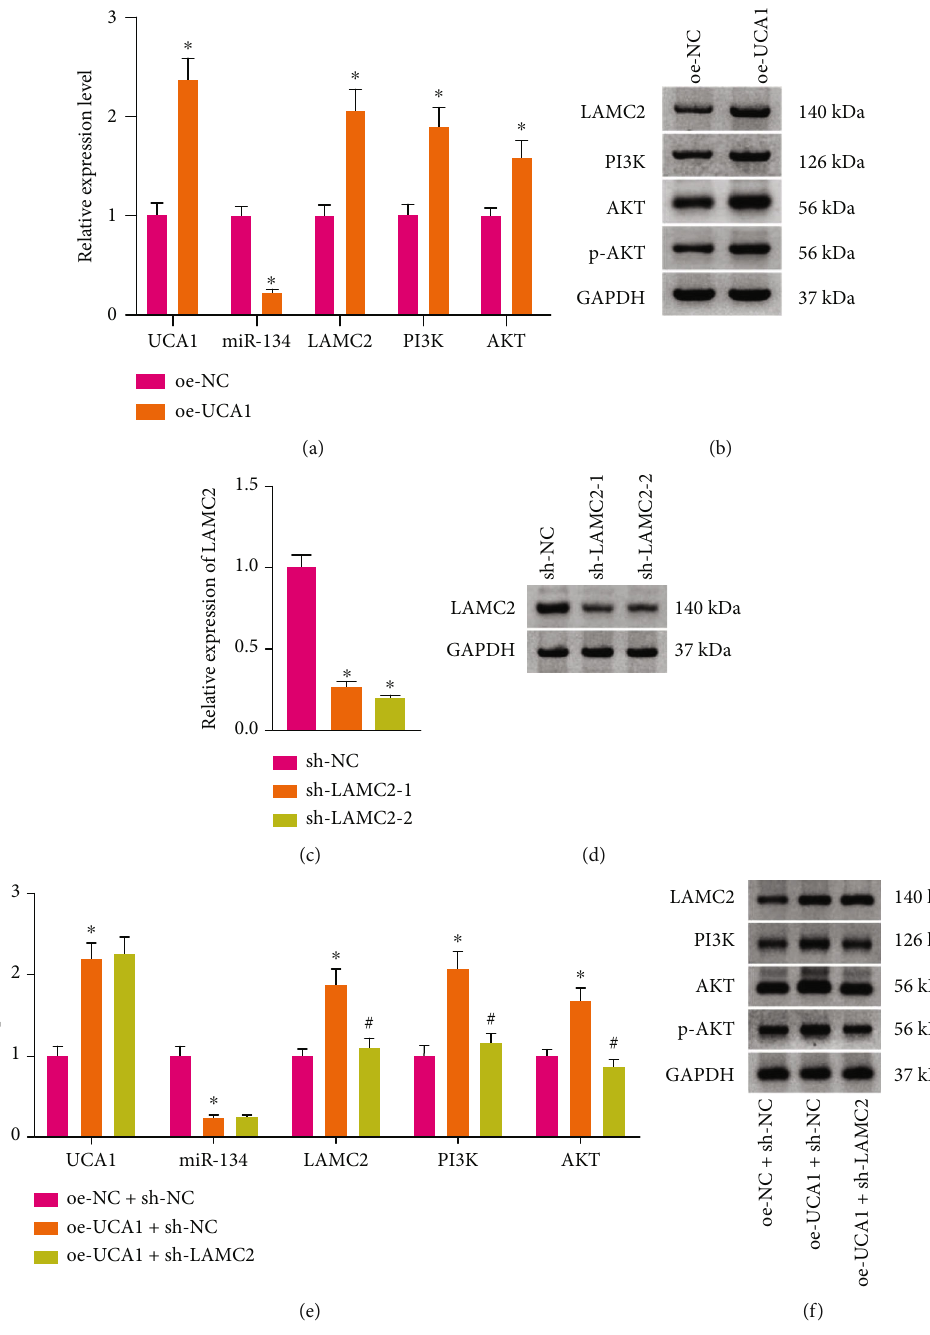
Figure 3: UCA1 modulates the PI3K/AKT pathway in macrophages via targeting LAMC2. (a) The expression of UCA1, miR-134, LAMC2, PI3K, and AKT in macrophages after overexpression- (oe-) UCA1 treatment, measured by RT-qPCR. (b) The protein expression of LAMC2, PI3K, AKT, and p-AKT in macrophages after oe-UCA1 treatment, detected by Western blot analysis. The silencing e ffi ciency of sh-LAMC2, veri fi ed by RT-qPCR (c) and Western blot analysis (d). (e) The expression of UCA1, miR-134, LAMC2, PI3K, and AKT in macrophages after oe-UCA1 and sh-LAMC2 treatment, determined by RT-qPCR. (f) The protein expression of LAMC2, PI3K, AKT, and p-AKT in macrophages, determined by Western blotting. ∗ p < 0 : 05 , # p > 0 : 05 . All cell experiments were repeated three